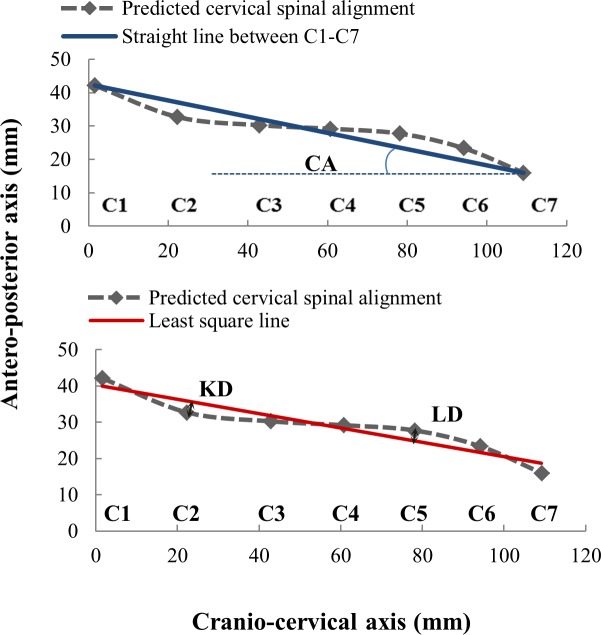
Illustration of the cervical spine alignment parameters: CA, cervical angle; LD, lordosis distance; KD, kyphosis distance.The dashed line is a cubic spline regressed by the vertebrae coordinates.